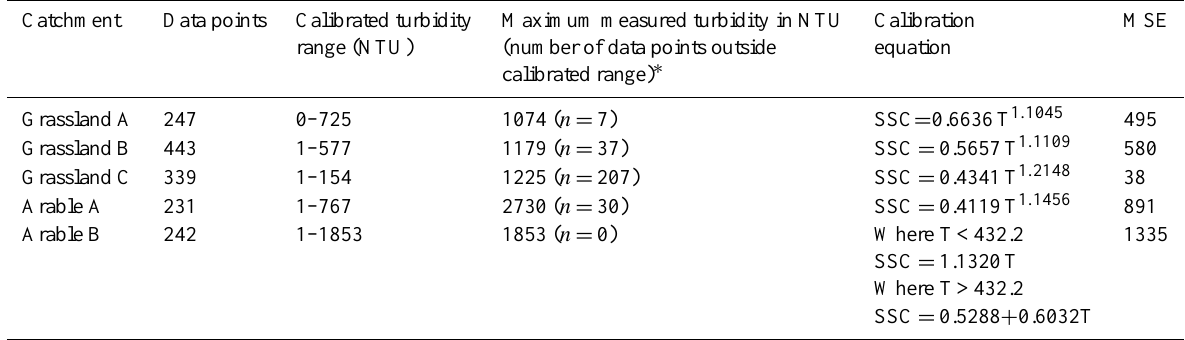
Table 2. Turbidity-suspended sediment calibration data-set summary and rating curve equations and fit parameters. Catchment Data points Calibrated turbidity Maximum measured turbidity in NTU Calibration MSE range (NTU) (number of data points outside equation calibrated range) ∗ Grassland A 247 0–725 1074 ( n = 7) SSC = 0.6636T 1 . 1045 495 Grassland B 443 1–577 1179 ( n = 37) Grassland C